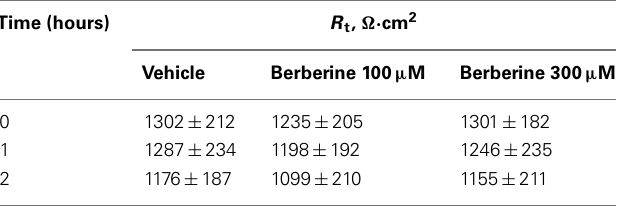
Table 1 | Effect of berberine on transepithelial resistance.